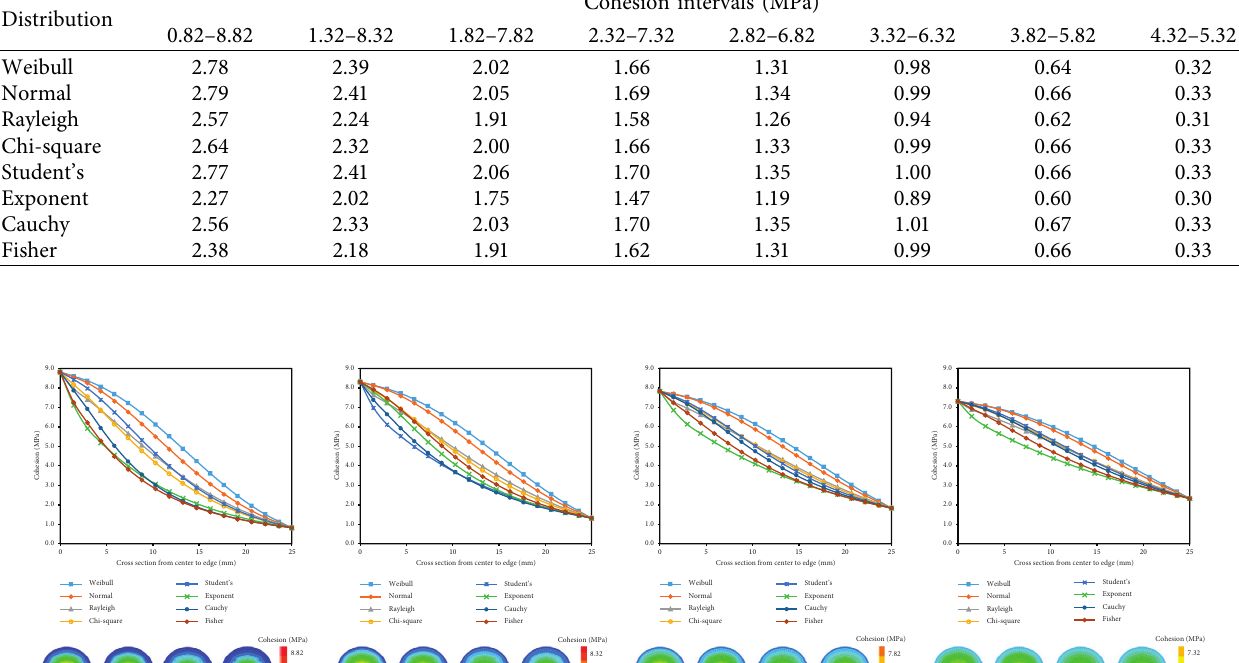
Table 7: Values of standard deviation of the eight probability distributions under eight cohesion scatter intervals. Distribution